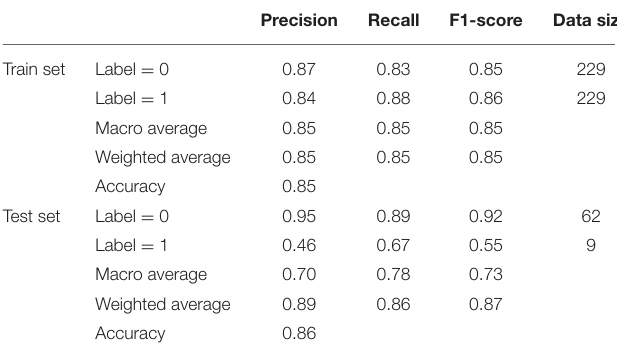
TABLE 5 | Summary of classification performance of RF model in the training and test set. Precision